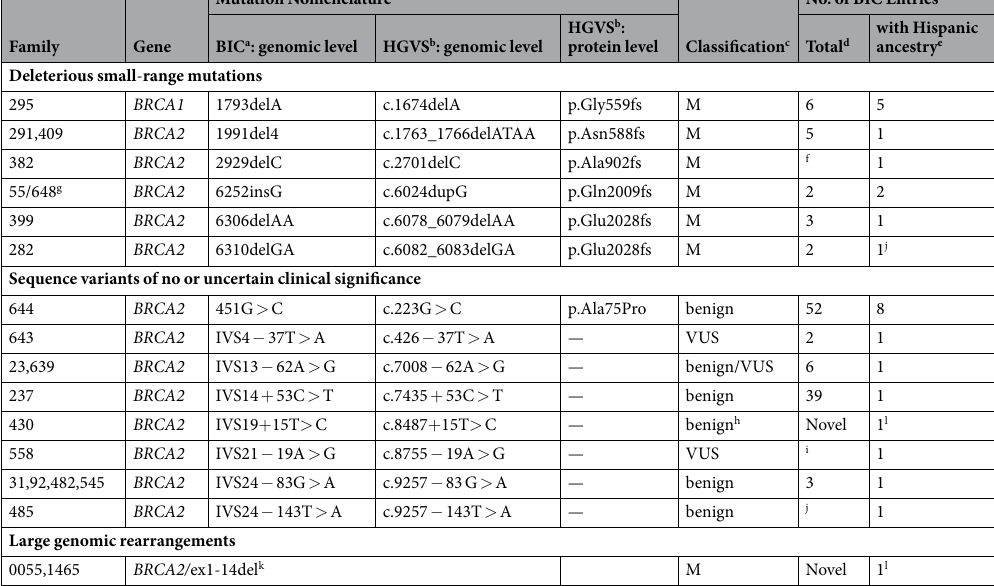
methods. In total, 71 (7%) BRCA1/2 mutations were identified: 56 (5.5%) in BRCA1 and 15 (1.5%) in BRCA2 . Mutation frequencies are shown in Table 4. No mutations were detected in the 1,023 healthy Col-BCCC controls. Penetrance of Colombian BRCA1/2 Founder Mutations.